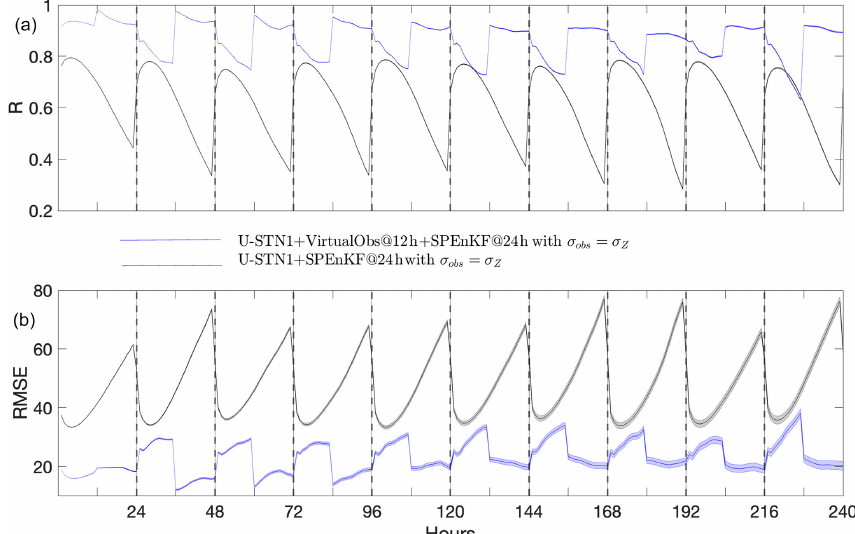
Figure 9. Same as Fig. 8 but with large observation noise, σ obs = σ Z .